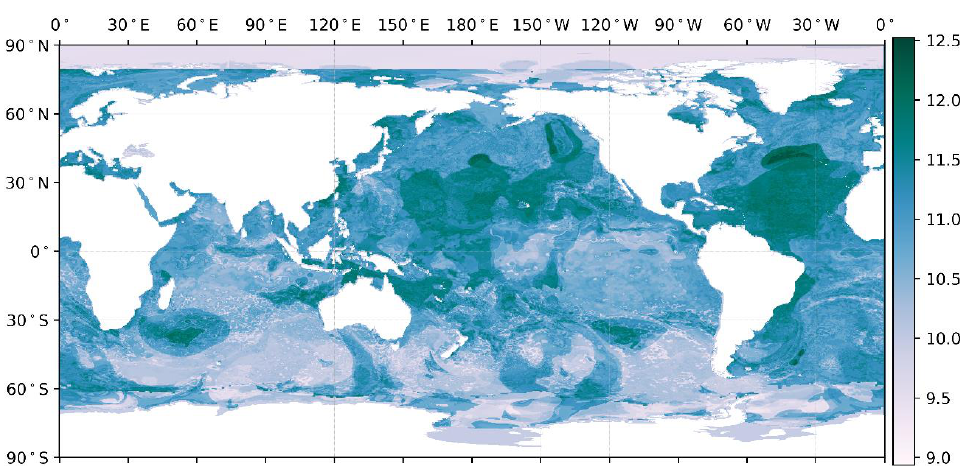
Figure 8. Predicted SOG map on 20 January 2018, East (knot).